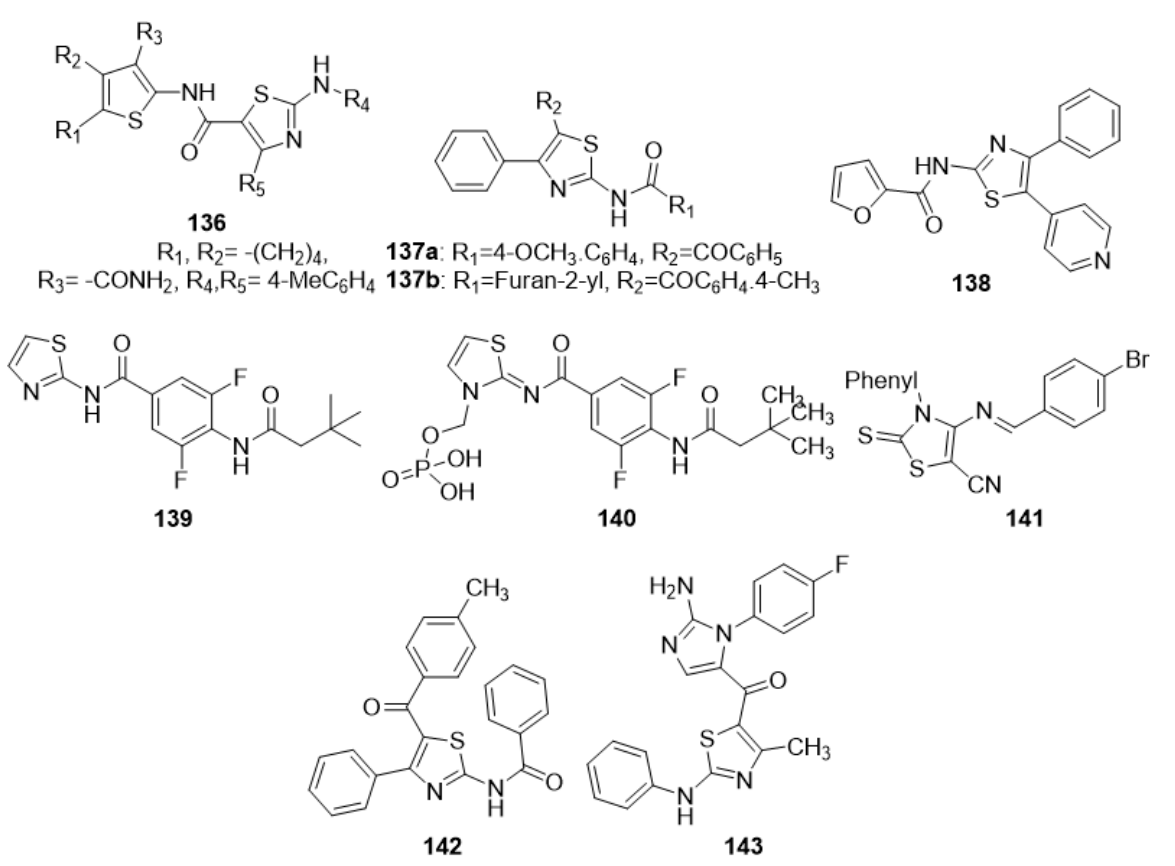
Figure 12. Recently designed and synthesized thiazoles as potential A1-receptor antagonist.